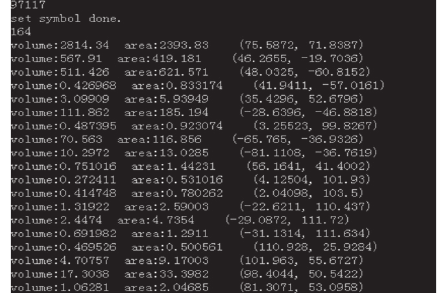
Figure 5: Wood surface’s grid graph in the Artec Studio 9 without color information.